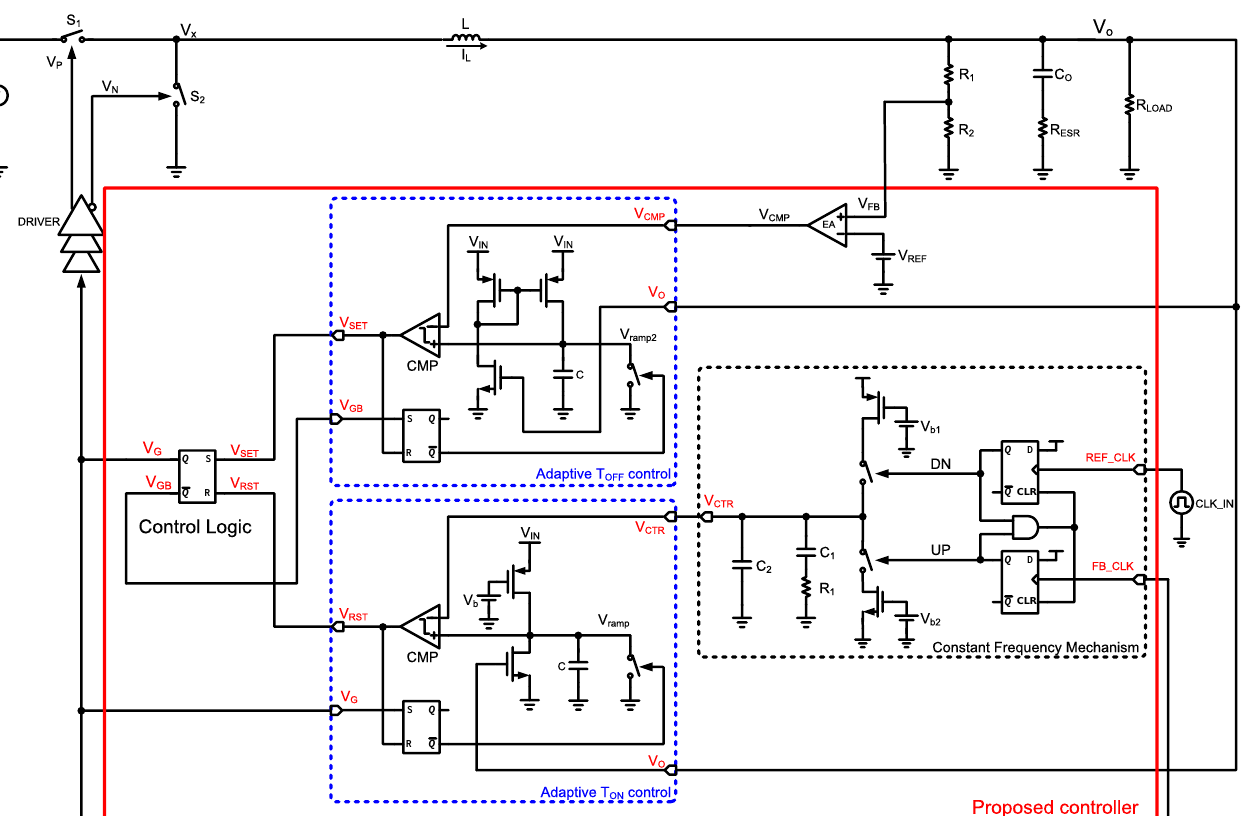
Figure 5. Circuit implementation of the proposed converter.